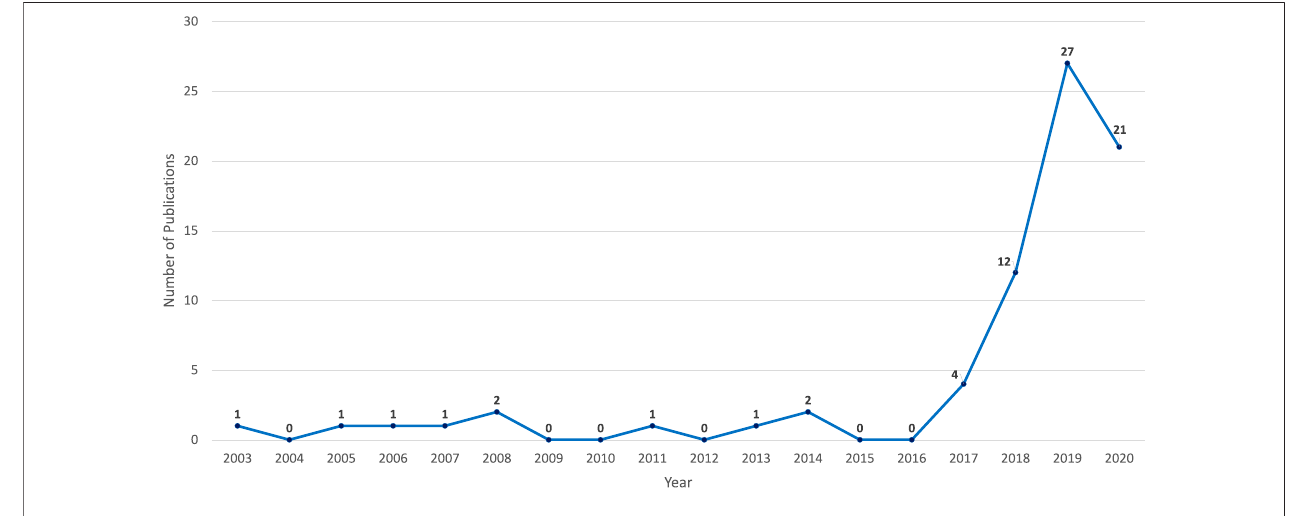
FIGURE 6 | Identi fi ed chatbot publications in education per